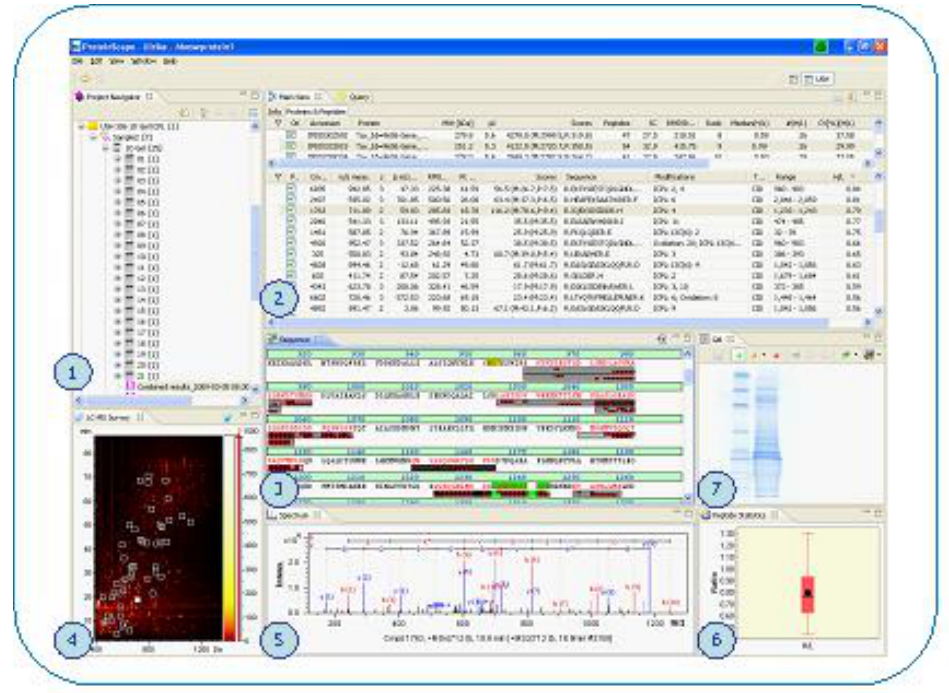
Fig. 1: Quantitation Project in ProteinScape. All Views can be easily switched ON and OFF and changed in size to see all relevant information